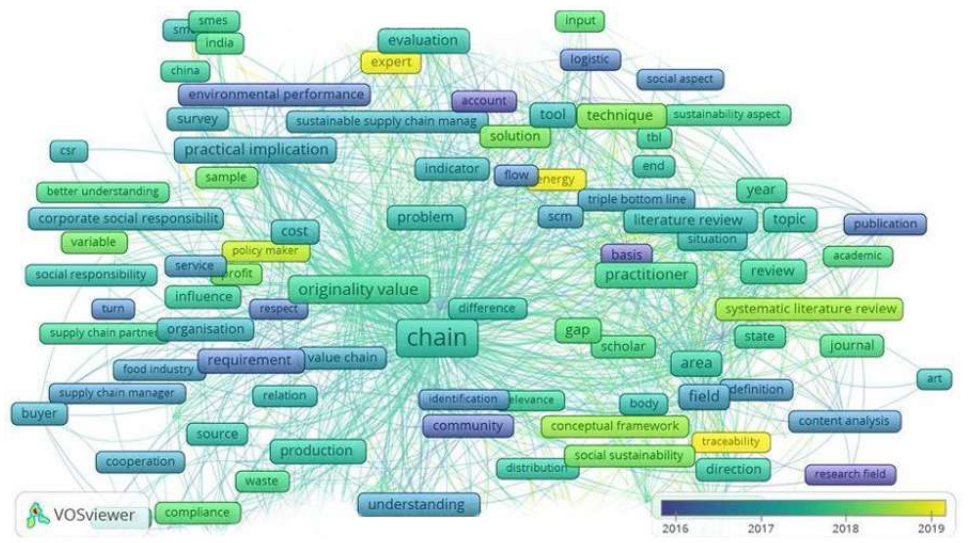
Figure 3. The overlay visualization of co-occurrence of keywords “sustainable supply chain” and “value chain” based on the SCOPUS articles, which was created by the authors using VOSviewer (version 1.6.17).